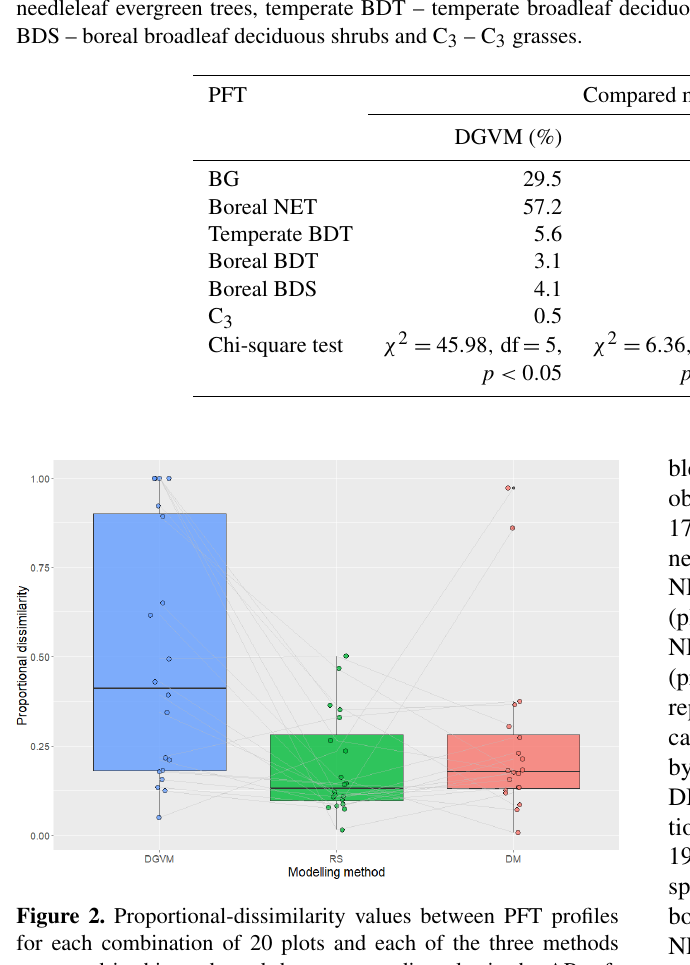
Table 2. PFT profiles (columns) aggregated across all 20 plots for the three methods compared in this study and the AR reference dataset. Results of comparisons of aggregated PFT profiles for each of the three methods with the reference are also given. DGVM – dynamic global vegetation model, RS – remote sensing, DM – distribution model and AR – reference dataset. BG – bare ground, boreal NET – boreal